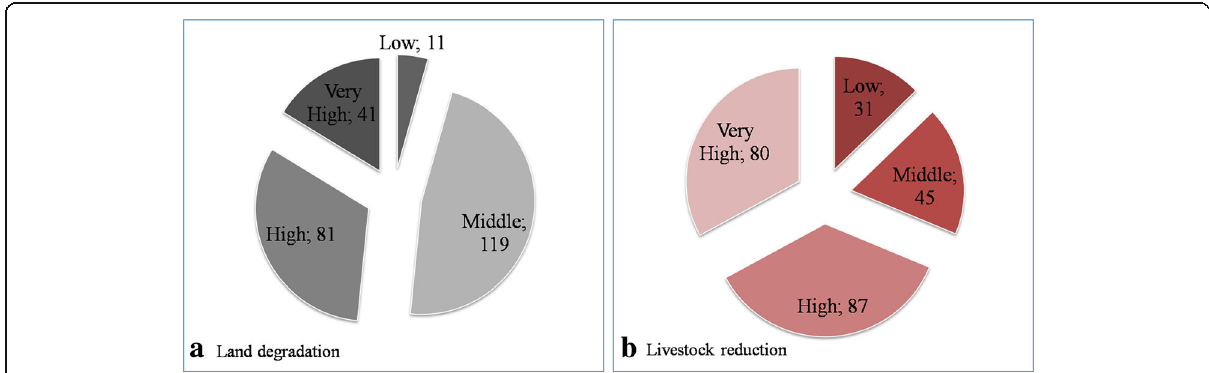
Fig. 5 Land degradation ( a ) and livestock reduction ( b ) variables of Drought (Supplementary